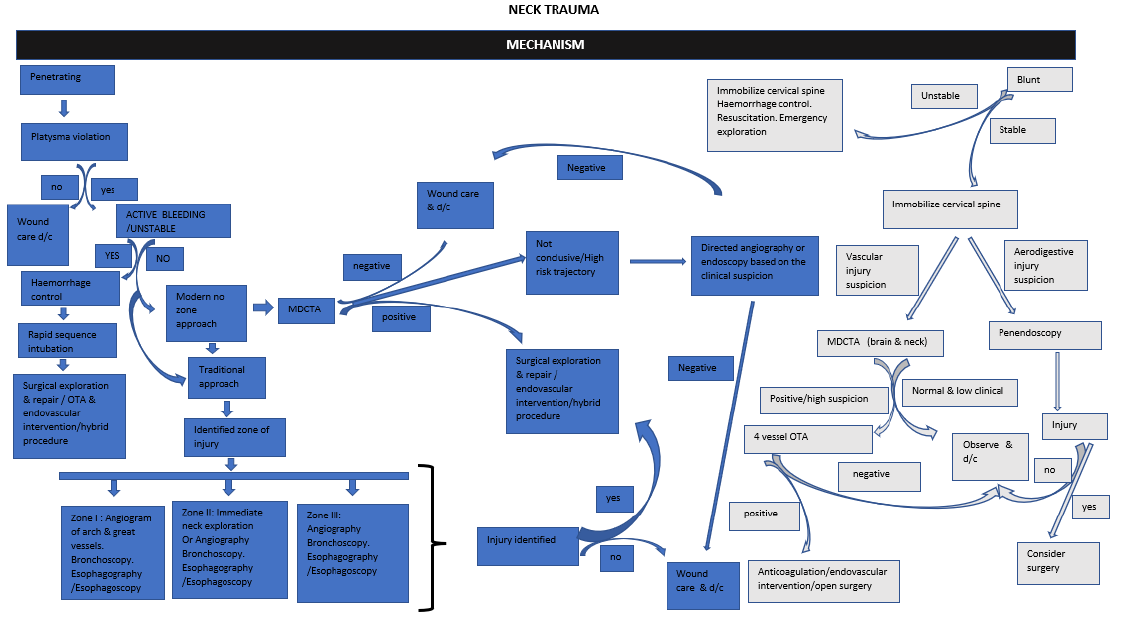
Figure 3. Suggested algorithm for approach to neck trauma. d/c − discharge; MDCTA − Multidetector Computed Tomographic Angiography.